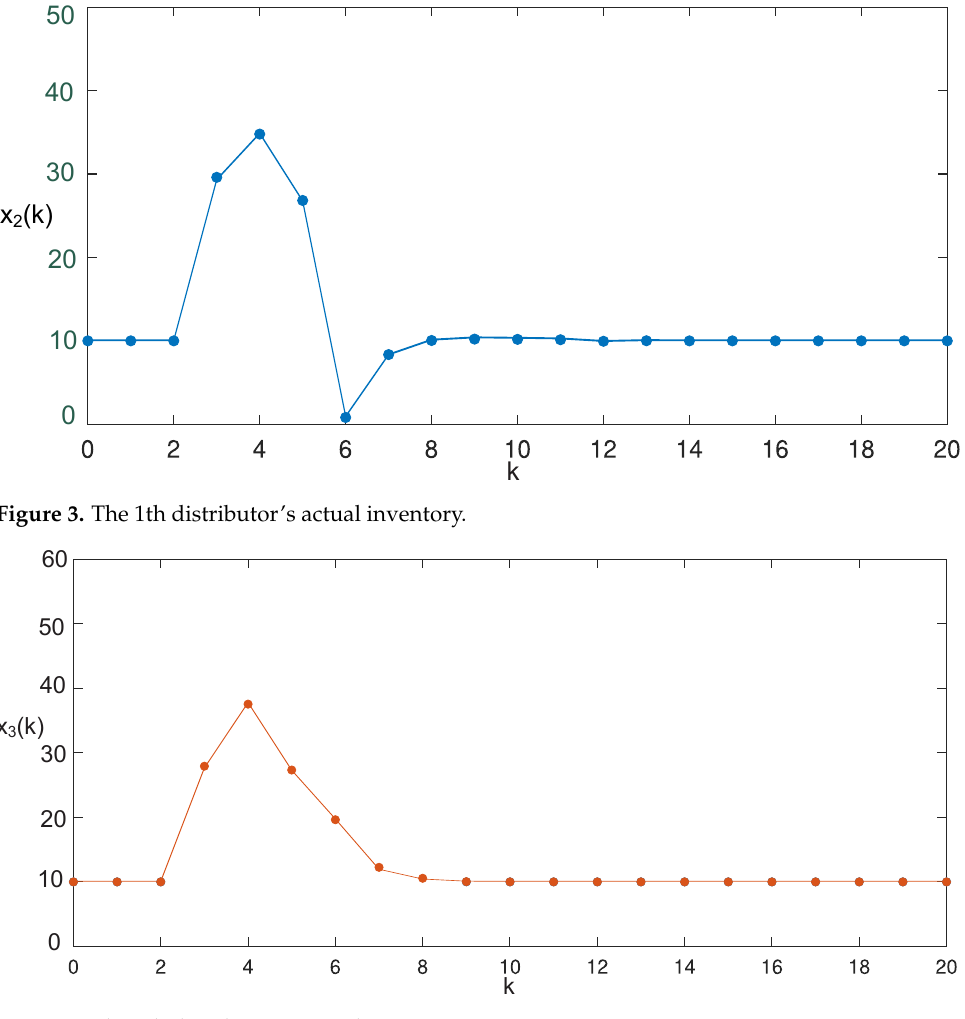
Figure 4. The 2th distributor’s actual inventory. Fig. 5. State-feedback closed-loop response to the impulsive distur- bance w ( k ) in Fig. 2 (top-left panel).